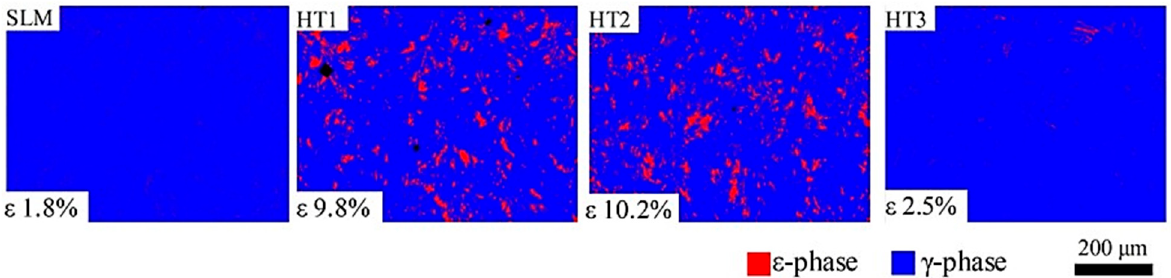
Figure 11. Phase distribution of the CoCr sample at different temperatures, exhibiting an increased ε phase and an increase in heating stage number [30].